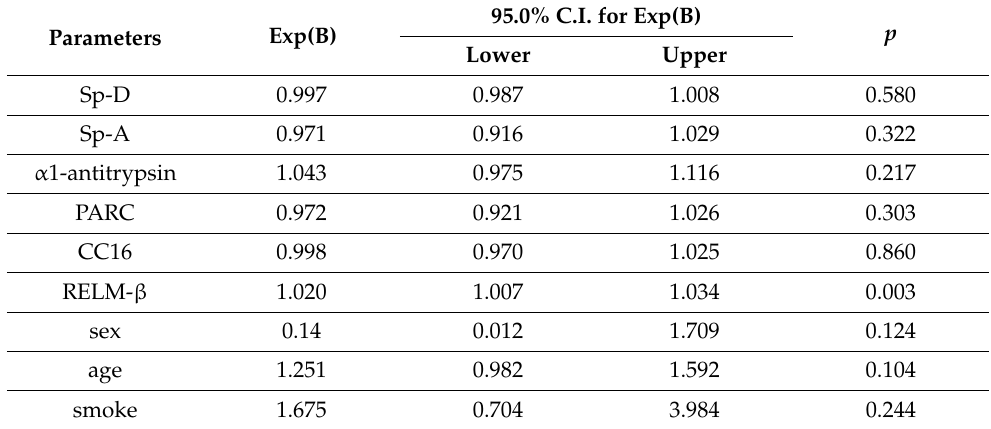
Table 3. Logistic regression analysis of the relative chance of developing bronchitis.